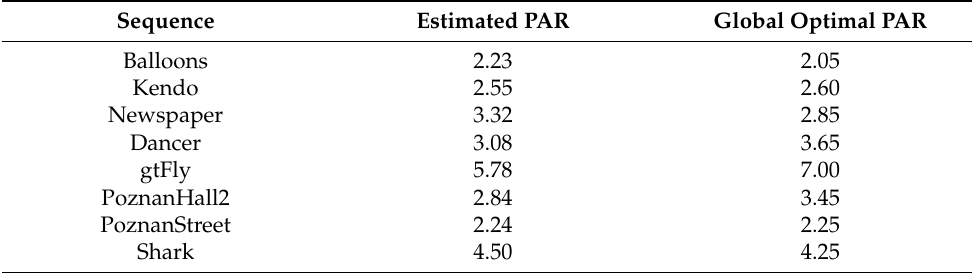
Table 2. Power allocation ratio of the 3D video sequences